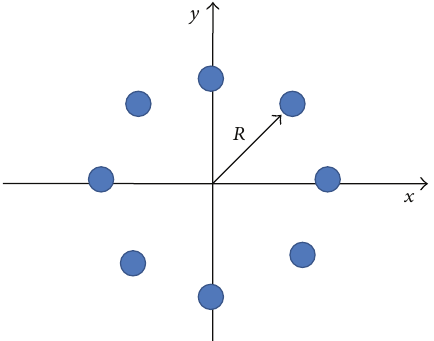
Figure 1: A circular array with 𝑁 = 8 equispaced nanospheres in the 𝑥 - 𝑦 , with circle’s radius 𝑅